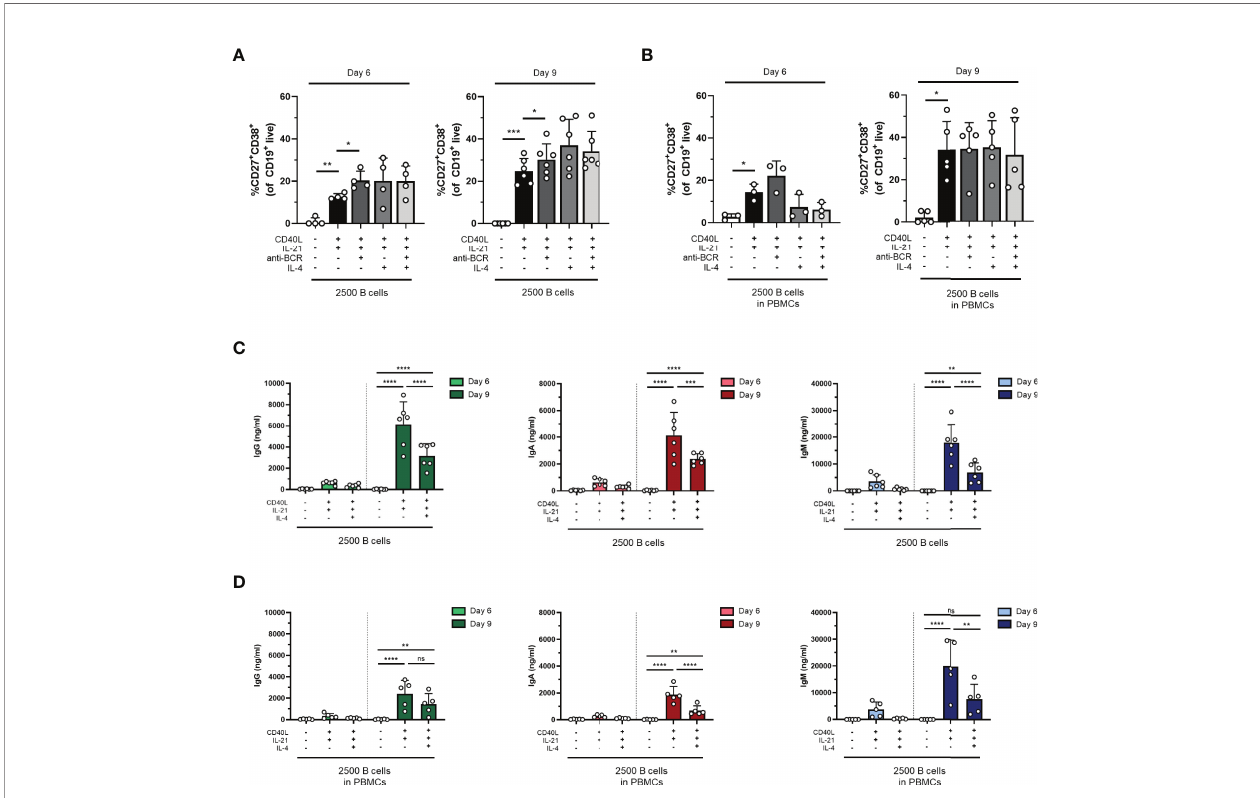
FIGURE 2 | The addition of anti-BCR stimuli in a T-cell-dependent stimulation results in increased B-cell differentiation, while IL-4 severely inhibits antibody production. Human primary B cells obtained from healthy donors were stimulated under conditions described in Figure 1A (condition II) and Supplementary Figure 2A (condition II.2, PBMC cultures) with or without anti-BCR [anti-Ig F(ab) 2 mix (5 µg/ml) targeting IgM, IgG, and IgA] and/or recombinant IL-4 (25 ng/ml). Frequencies of CD27 + CD38 + B cells on day 6 and day 9 in (A) condition II and (B) condition II.2 ( n = 4 – 6). (C, D) Total secretion of IgG, IgA, and IgM measured in culture supernatants of eligible conditions after 6 and 9 days (C) without PBMCs (condition II) and (D) within PBMC cultures (condition II.2). Each data point represents the mean of an individual donor with duplicate culture measurements. Mean values are represented by bars and the error bars depict SEM. P -values were calculated using one-way ANOVA with Dunnett ’ s multiple comparison test (A, B) or two-way ANOVA with Sidak ’ s multiple comparison test (C, D) . * P ≤ 0.05, ** P ≤ 0.01, *** P ≤ 0.001, **** P ≤ 0.0001. ns, not signi fi